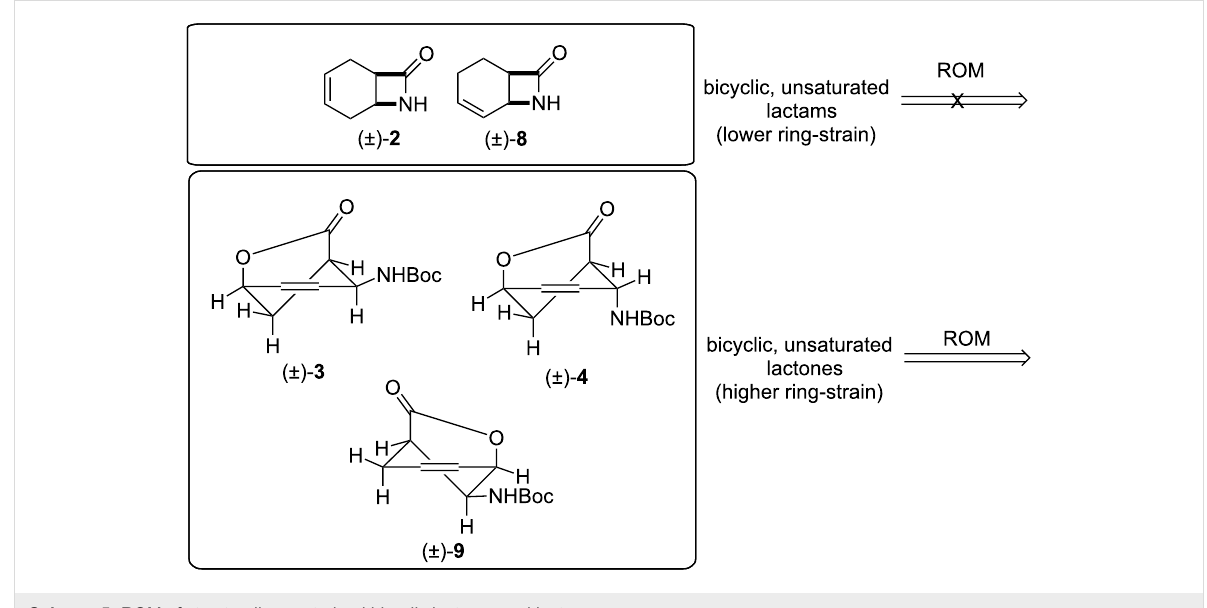
Scheme 5: ROM of structurally constrained bicyclic lactones and lactams.